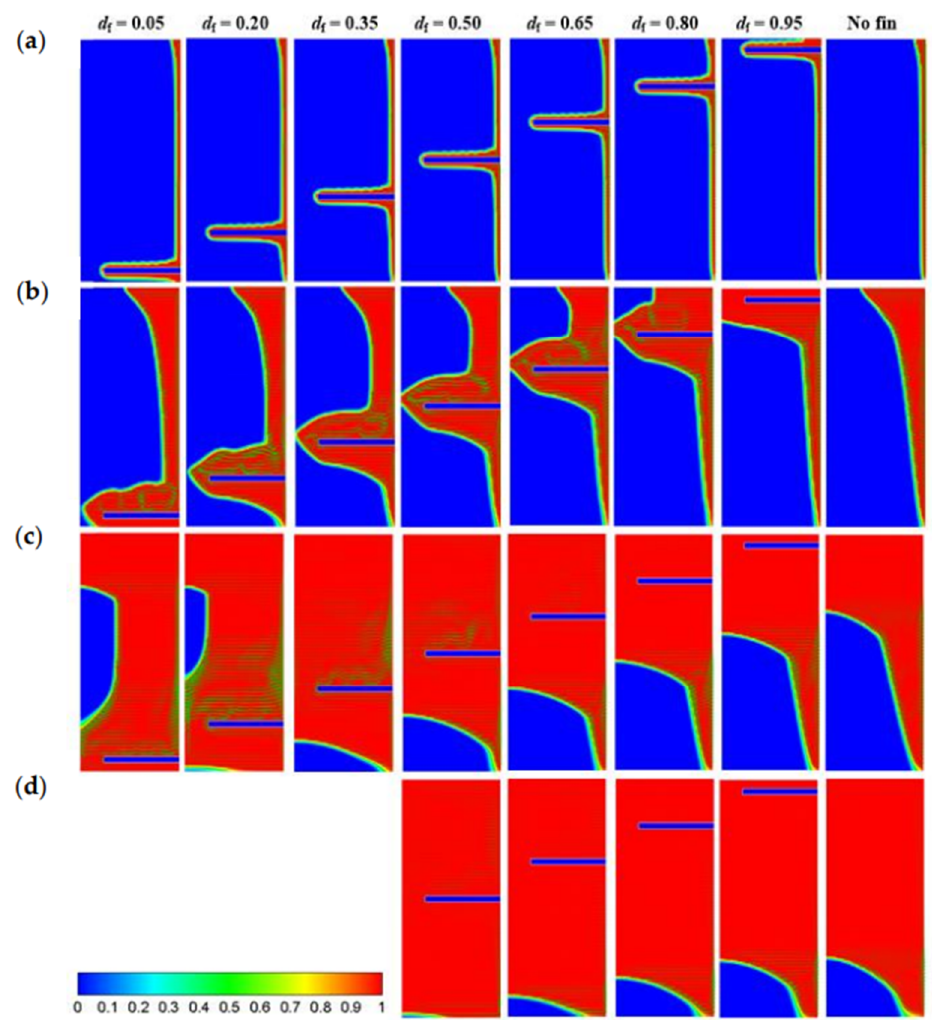
Figure 5. Instantaneous liquid fraction contours and velocity vectors for different d f and no-fin case at ( a ) t = 300 s, ( b ) t = 1800 s, ( c ) t = 4800 s, and ( d ) t = 8400 s